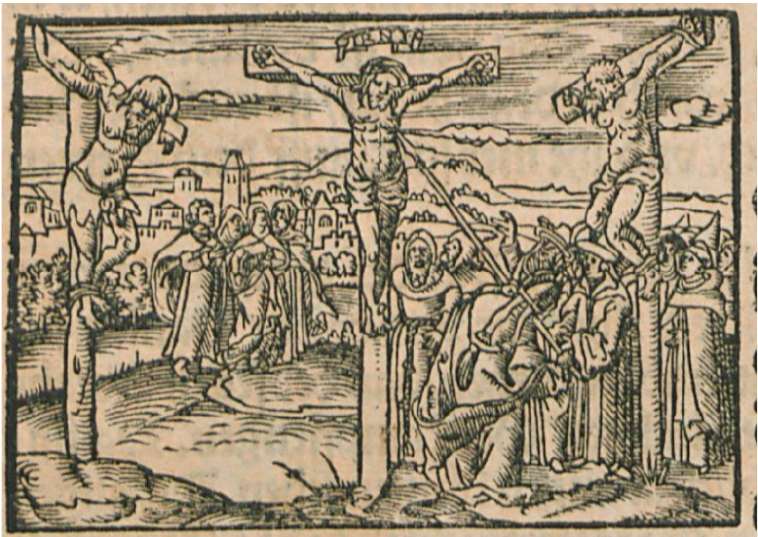
Figure 10. Woodcut recurring in books published by vom Berg and Neuber: Crucifixion [R 29], in (Luther 1545a), fol. CLXIv (Halle, Salle, Universitäts- und Landesbibliothek Sachsen-Anhalt, urn:nbn:de:gbv:3:1-102424).